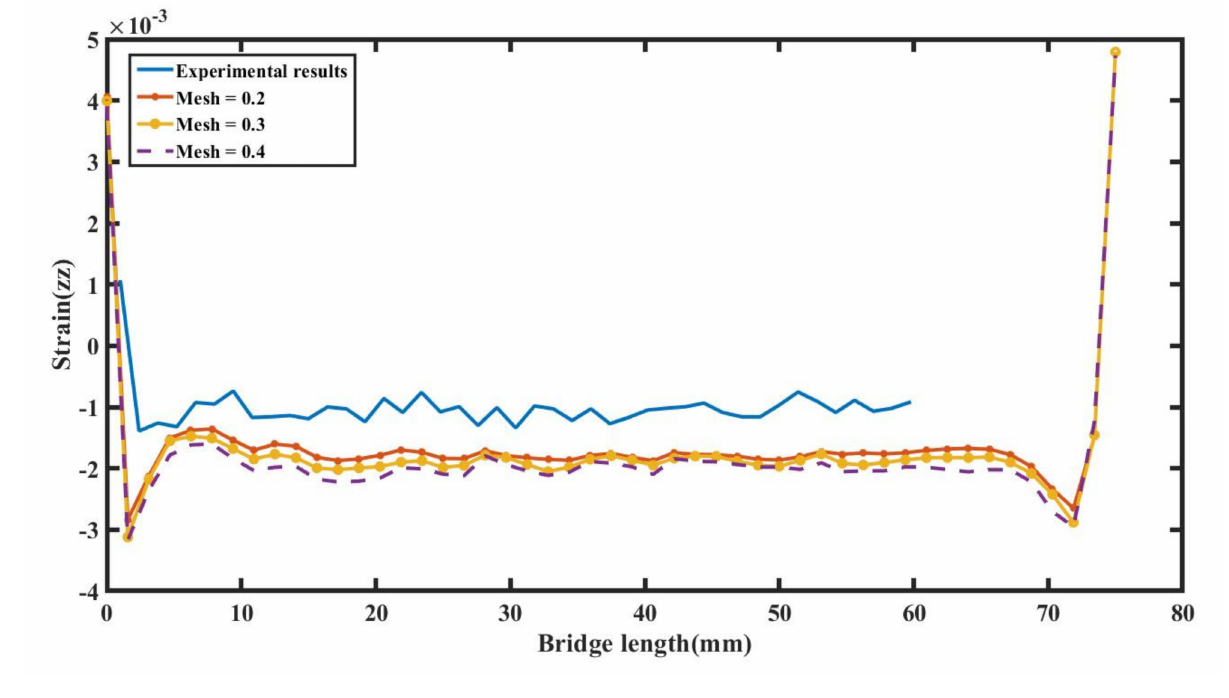
Figure 8. Mesh convergence study. Table 2. Discrepancy in different mesh size